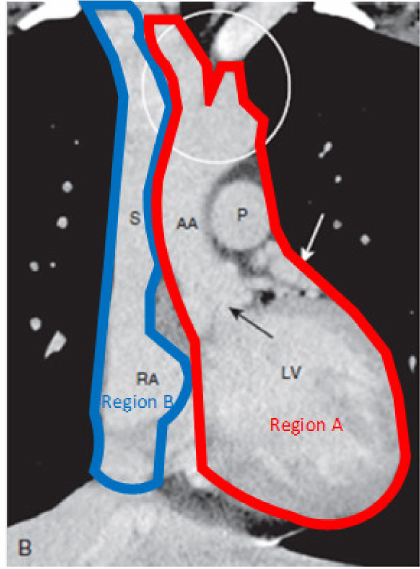
Figure 1. Human heart computerized tomography scan